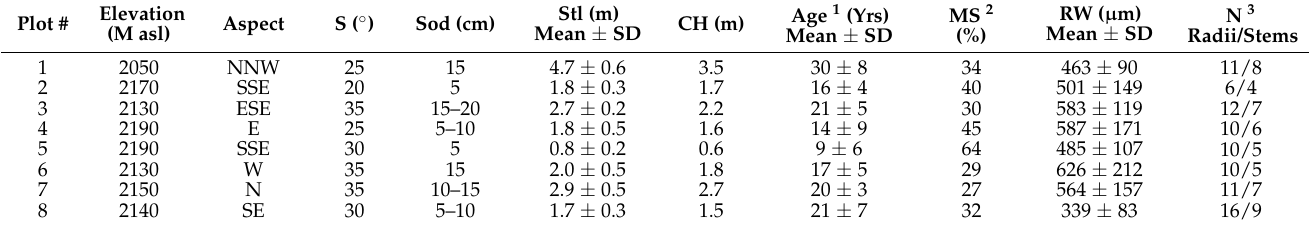
Table 1. Site description and characteristics of selected Alnus alnobetula stands with elevation (m above sea level (asl)), slope (S, ◦ ), soil depth (SoD, cm), stem length (StL, m), canopy height (CH, m), age (years) mean sensitivity (MS, %), ring width (RW, µ m) and sample depth (n radii/stems). Mean values ± standard deviation (SD) are shown for stem length, age and ring